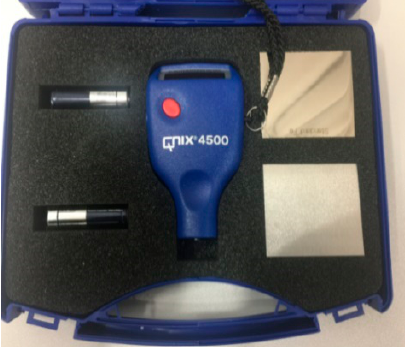
Figure 10. Coating thickness gauge.